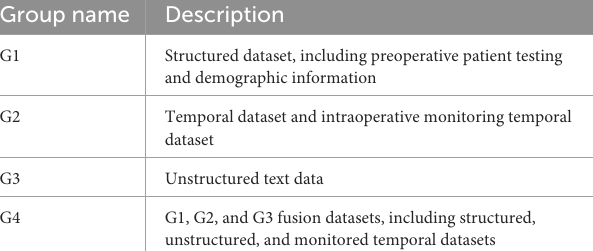
TABLE 2 Group experiment